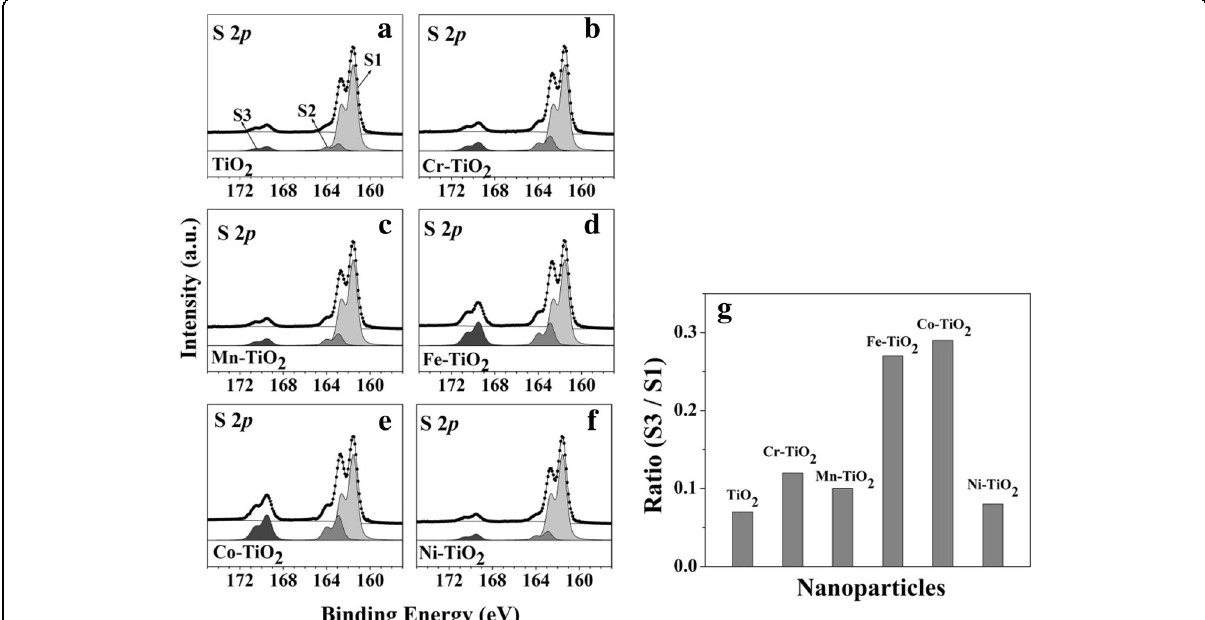
Fig. 6 (Left panel) HRPES S 2 p core-level spectra obtained after the catalytic oxidations of 180 L 2-ATP (the saturation exposure in our system) on anatase TiO 2 and 5 mol% TM-TiO 2 ( a TiO 2 , b Cr-TiO 2 , c Mn-TiO 2 , d Fe-TiO 2 , e Co-TiO 2 , and f Ni-TiO 2 ). (Right panel) g The plot for intensity ratio between S3 ( − SO 3 H) and S1 ( − SH) of anatase TiO 2 and the five TM-TiO 2 , indicating their catalytic activities in the oxidation of 2-ATP, for 180-l exposures under 365 nm UV